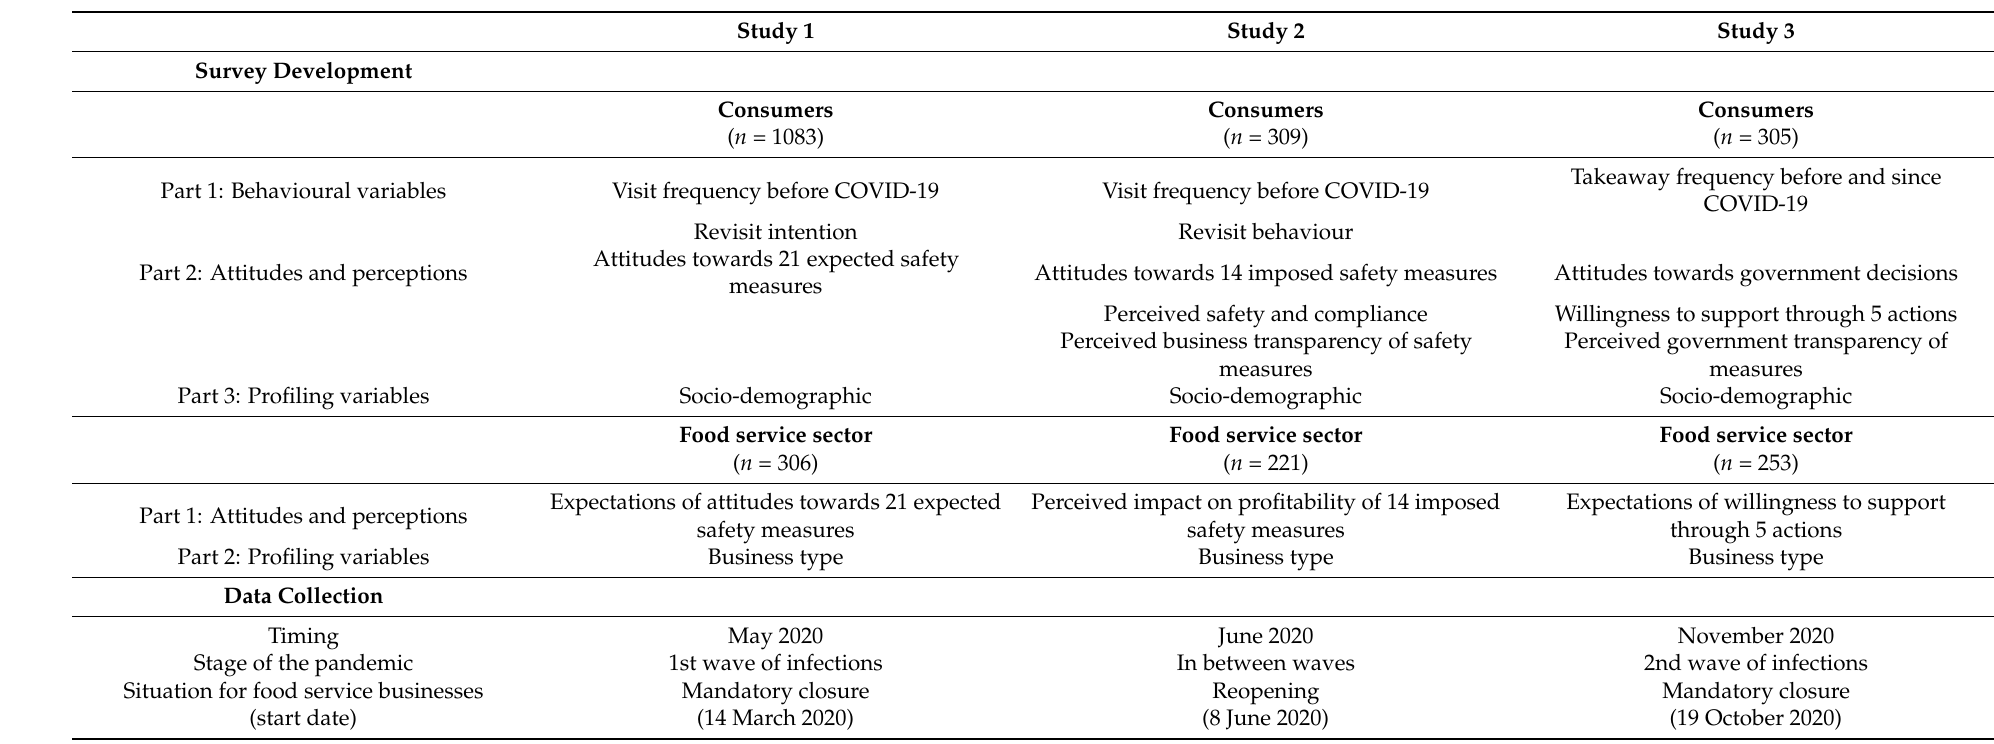
Table 1. Overview of survey development and data collection for the three